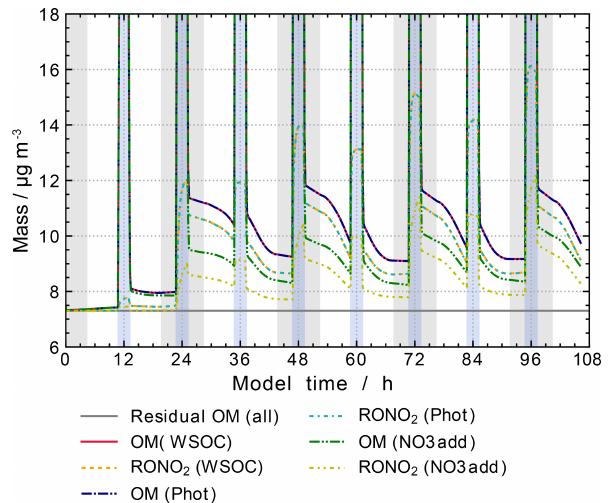
Figure 14. Processing of the organic mass fraction in the sensi- tivity runs investigating the influence of sink and source reactions for organic nitrates on aqueous-phase chemistry and composition. In addition to the scenario “WSOC”, rate constants of all NO 3 reactions with unsaturated organic compounds have been set to 10 7 M − 1 s − 1 in scenario “NO3add”, and photolysis reactions with j = 3 . 6 × 10 − 7 s − 1 have been added in scenario “Phot”. Cloud pas- sages are shaded blue and night-time periods are shaded grey. Sce- nario names used in the legend are explained in Appendix A.2.